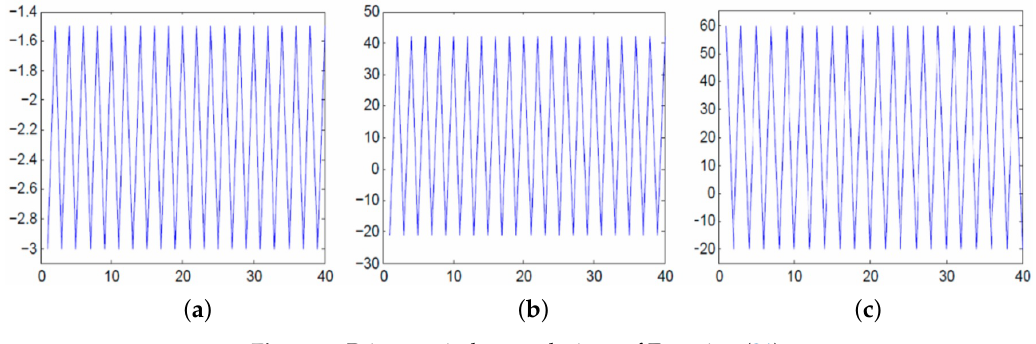
Figure 2. Prime period two solutions of Equation (21).